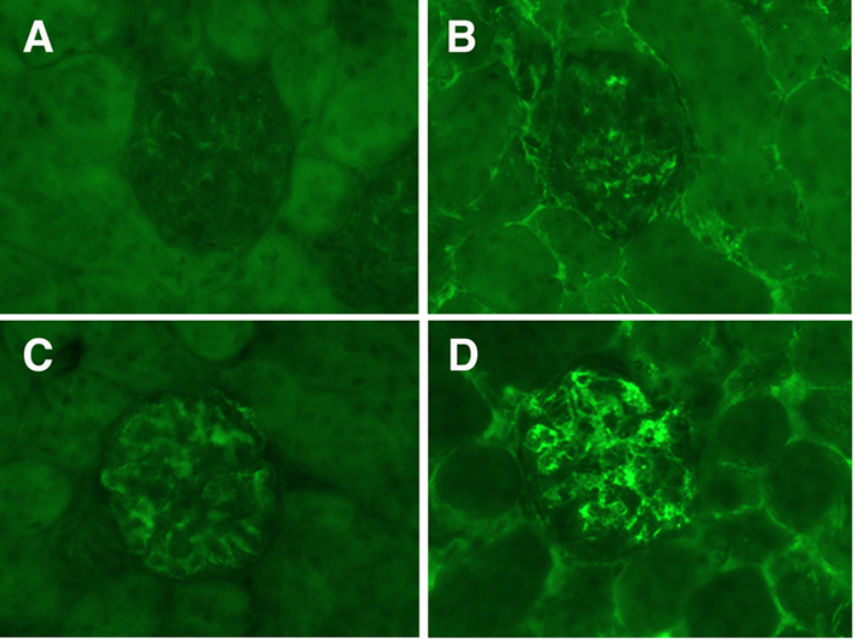
Figure 9. Inhibition of immune complex renal damage in T reg treated mice. Typical kidney sections demonstrating less severe IgG and IgM deposition in mice receiving adoptive T reg transfer (Figure 6A–B respectively) as compared to mice receiving either control therapy (T eff control mouse, Figure 6C–D).